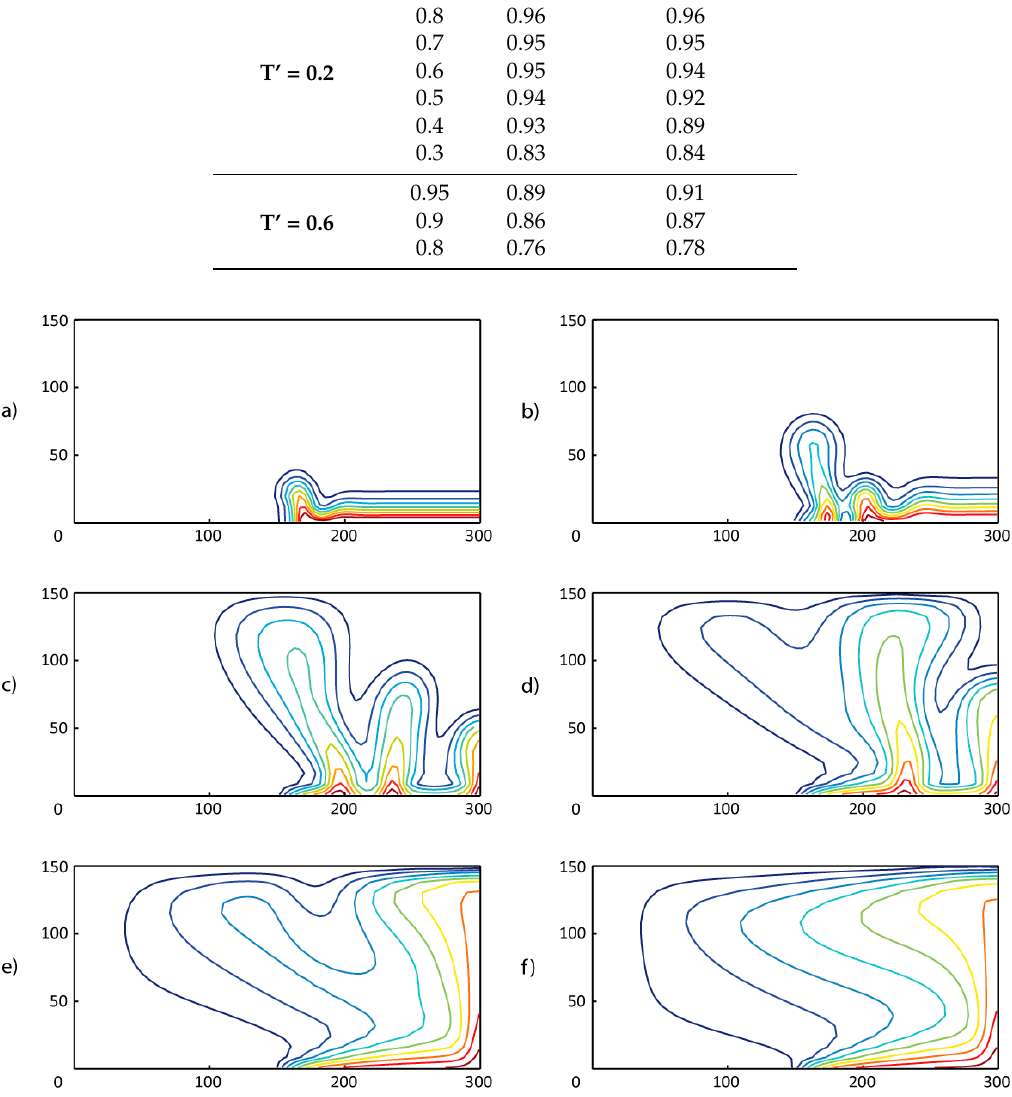
Figure 9. Evolution of transient to steady state temperature patterns for the Elder problem from the initial conditions ( a ) to the steady-state ( f ). initial conditions ( a ) to the steady-state ( f